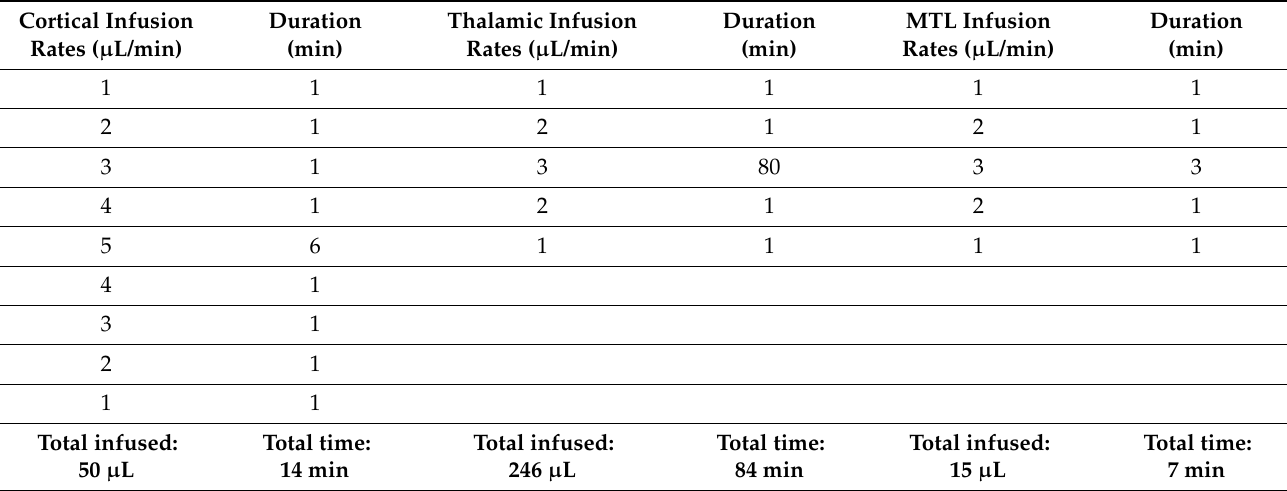
Table 3. Gel infusion rates. Medial temporal lobe